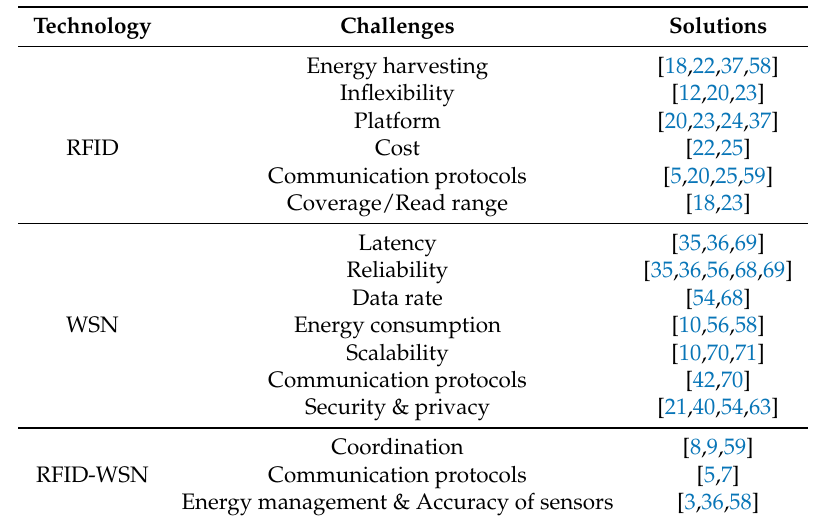
Table 3. Summary of RFID and WSN technologies, challenges, and solutions proposed in the state of the